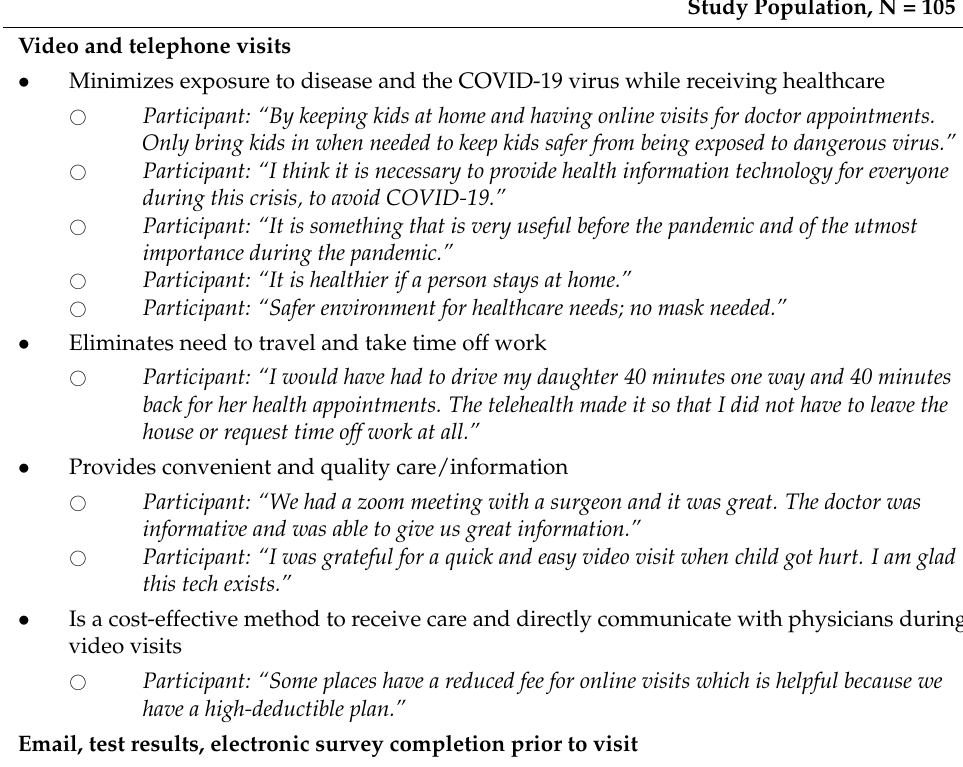
Study Population, N = 105